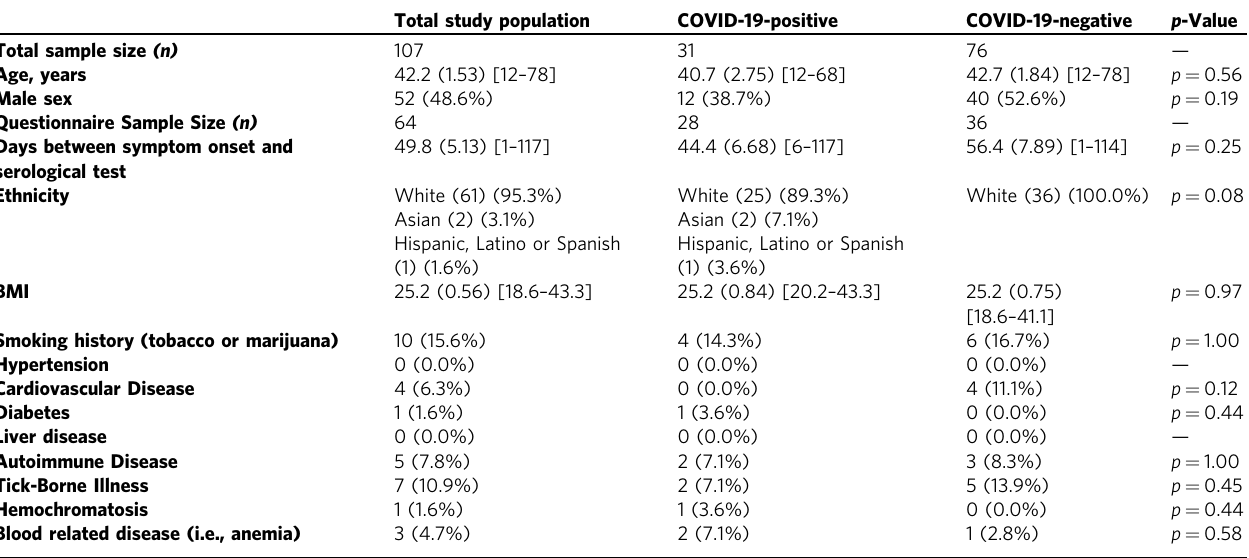
Table 2 Demographic and clinical characteristics of the Colorado cohort including COVID-19-positive and COVID-19-negative